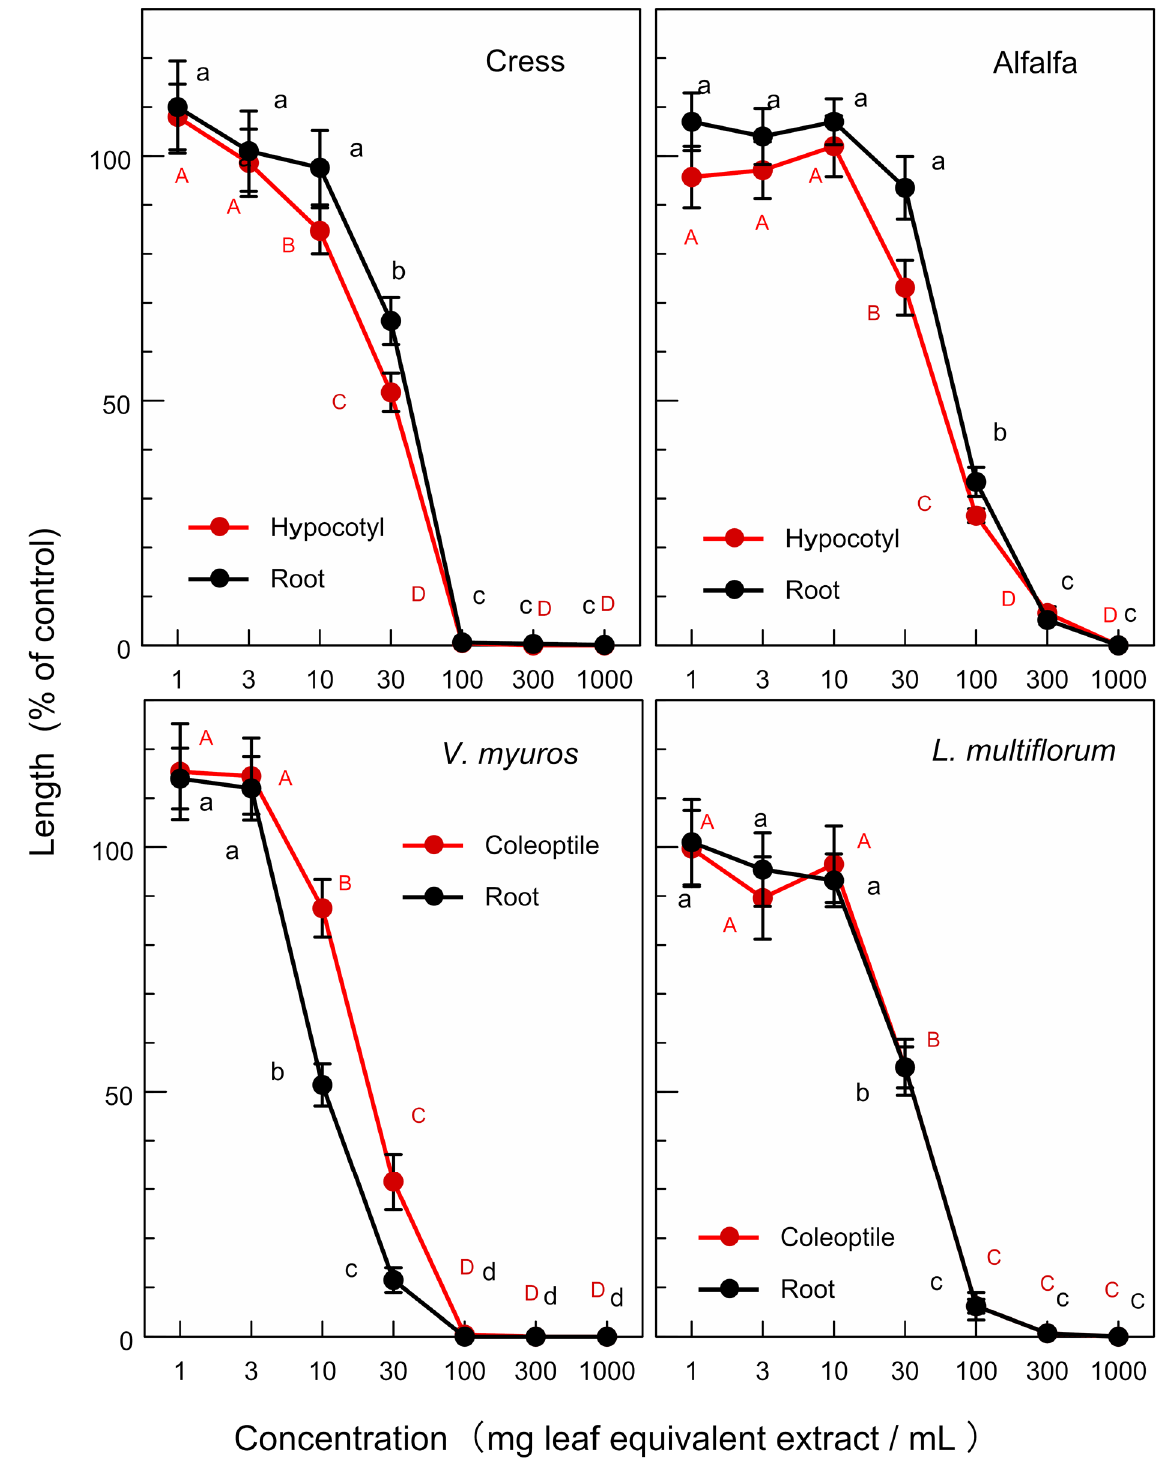
Figure 5. Effects of the extracts of O. × fortunei leaves on the growth of the hypocotyls and roots of cress and alfalfa, and the growth of the coleoptiles and roots of L. multiflorum and V. myuros . Concentration (mg leaf equivalent extract/mL) indicates the concentration of tested sample corresponding to the extracts obtained from 1, 3, 10, 30, 100, 300, and 1000 mg leaves per mL. Different letters on the symbols in the same panels indicate significant differences (Tukey’s HSD test, p ≤ 0.05).